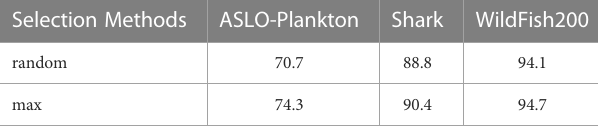
TABLE 6 . Ablative experiments on token-selective